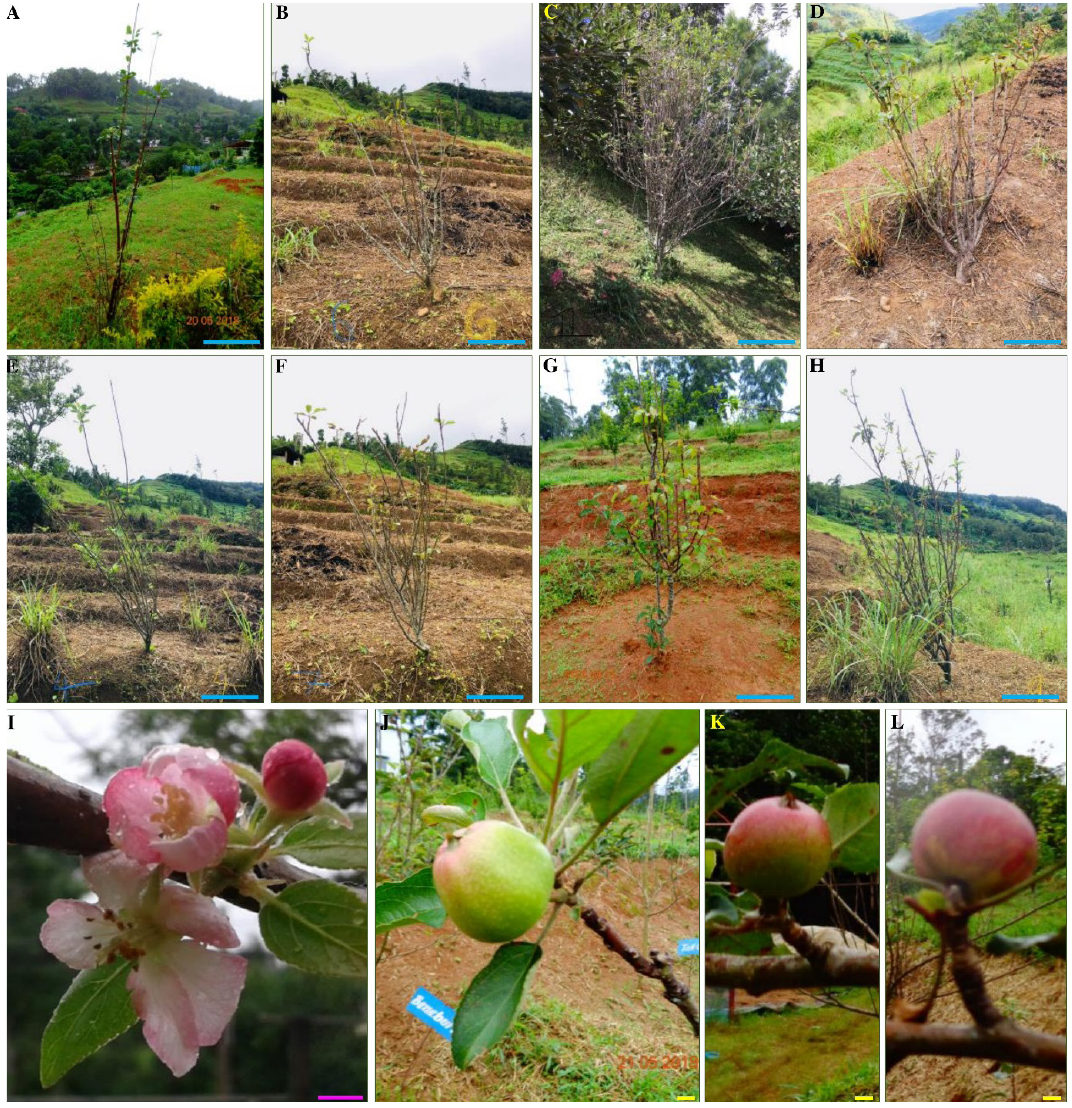
Figure 4: A set of apple trees currently growing in Sri Lanka. A-H: Eight different trees; I: Flower cluster; J: Fruits nearing harvesting stage. The scale bars for trees, flower and fruits represent 40 cm and 1 cm